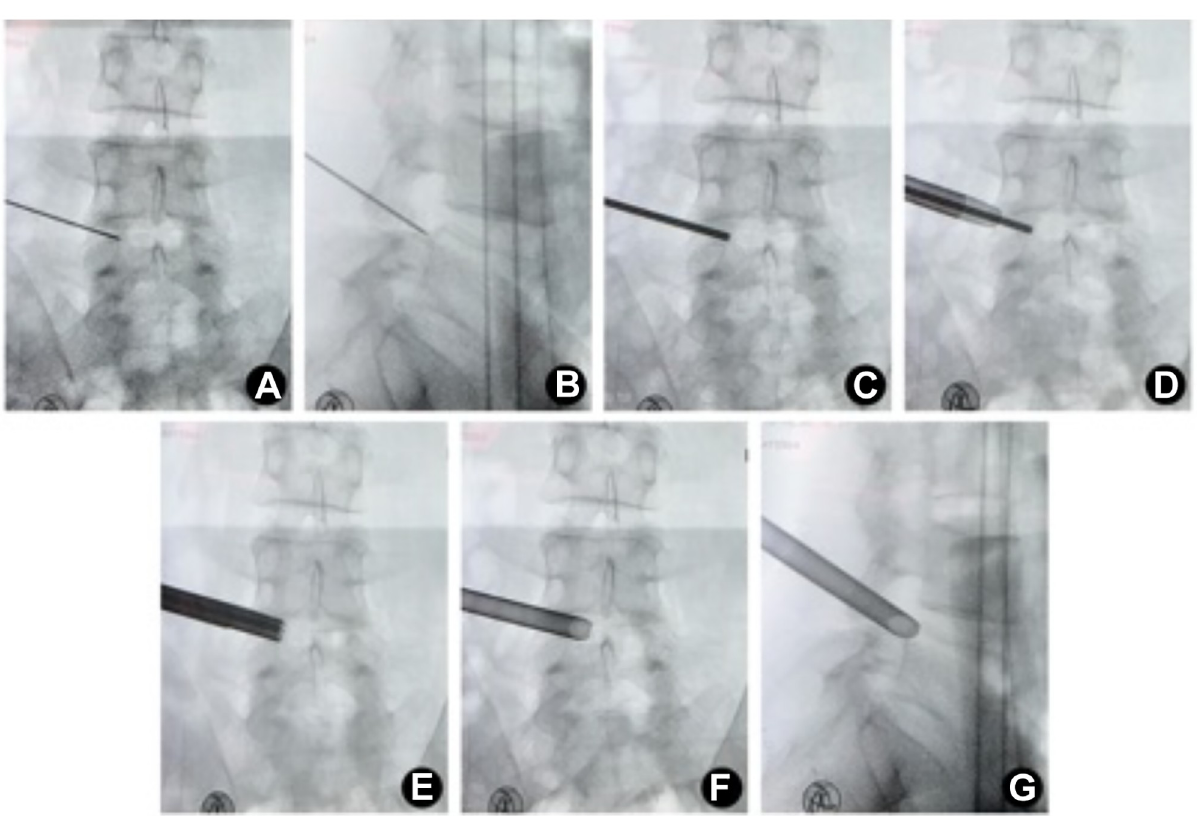
Fig 2. Intraoperative fluoroscopy. (A) The anteroposterior fluoroscopy after placing the puncture needle. (B) The lateral fluoroscopy after placing the puncture needle. (C) The fluoroscopy after placing the primary guide rod. (D) The fluoroscopy after placing the tongue-shaped protective sheath. (E) The anteroposterior fluoroscopy after placing the working cannula. (F) The lateral fluoroscopy after placing the working cannula.